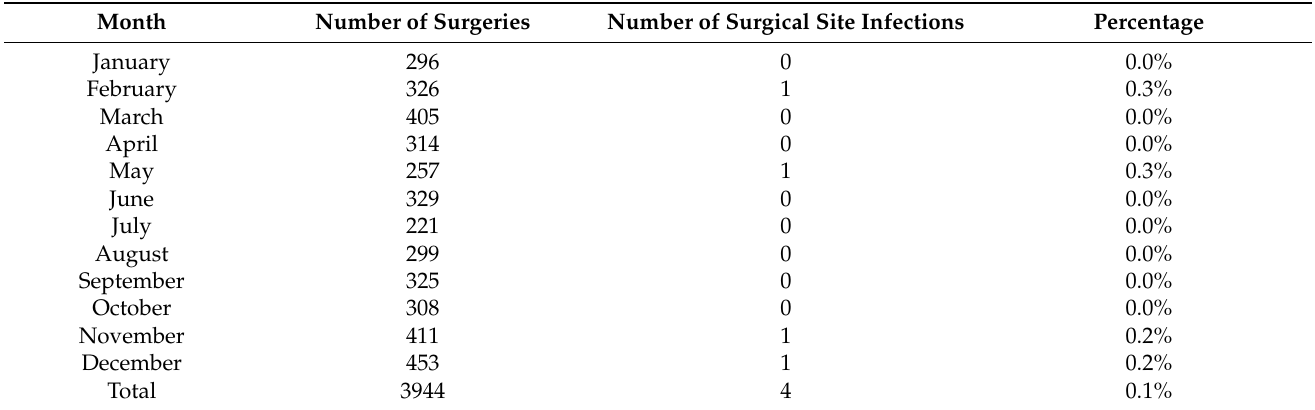
Table 1. The rate of surgical site